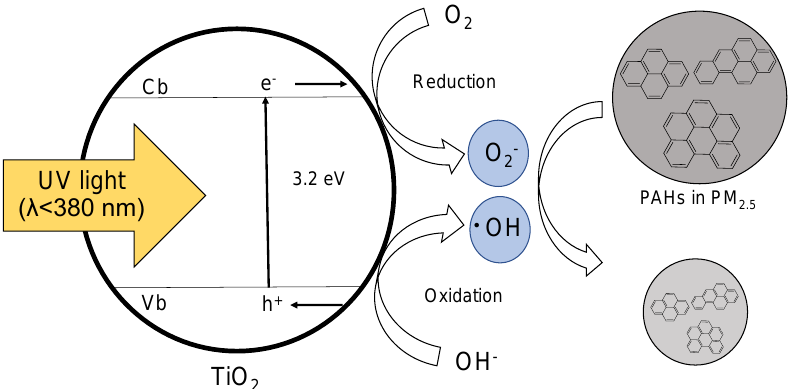
Figure 1. Conceptual schematic of the photocatalytic degradation of polycyclic aromatic hydrocar- bons (PAHs) in fine particulate matter (PM 2.5 ).